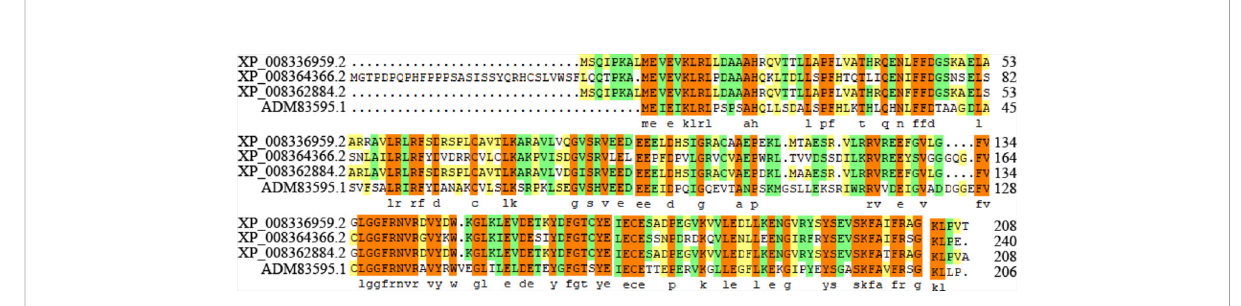
FIGURE 1 Amino acid sequence alignment analysis of MdTTM1, MdTTM2, MdTTM3, and HpAC1. The alignment analysis was conducted with the software